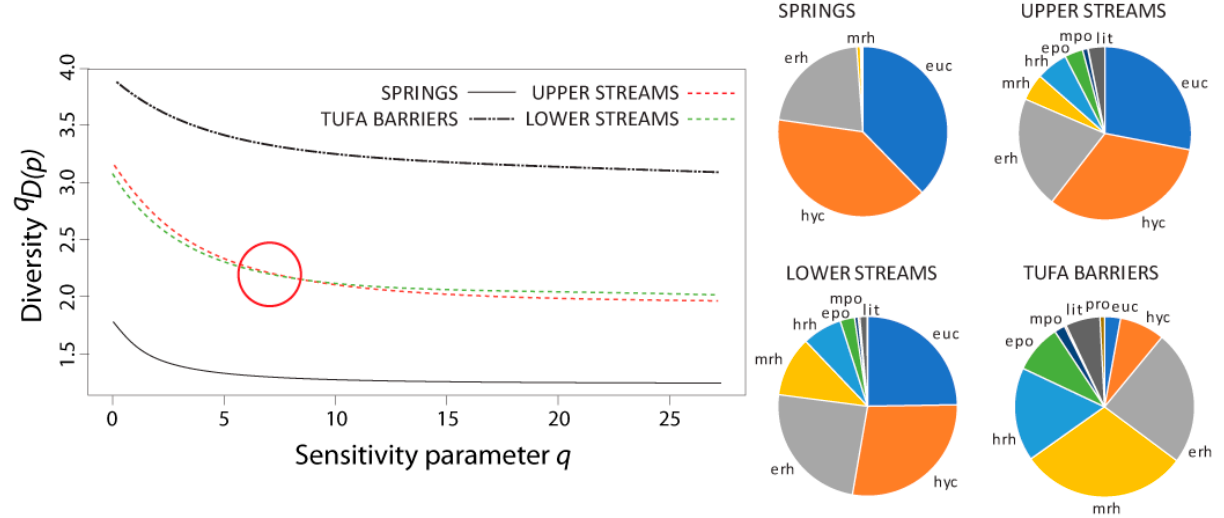
Figure 6. Diversity profiles of caddisfly communities from four different freshwater karst habitat types using a similarity matrix based on specific zone-preferring groups (longitudinal zonation). The ratio of specific species with stream zonation preferences in different habitat types are displayed next to the profile. The red circle denotes the intersection between the curves for the upper and lower streams. Abbreviations for zone-preferring groups (longitudinal zonation): eucrenal = euc; hypocrenal = hyc; epirhithral = erh; metarhithral =mrh; hyporhithral = hrh; epipotamal = epo; metapotamal = mpo; hypopotamal = hpo; littoral = lit; profundal = pro. (Springs: proportion of hyp, epo, mpo and hpo was less than 1%; lower streams: proportion of hpo and pro was less than 1%; tufa barriers proportion of hpo was less than 1%—not shown).